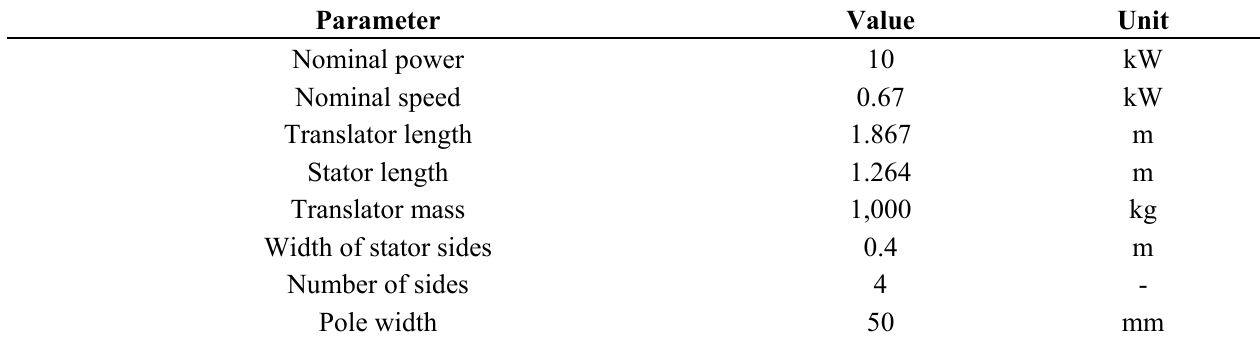
Table 5. Main parameters of the linear